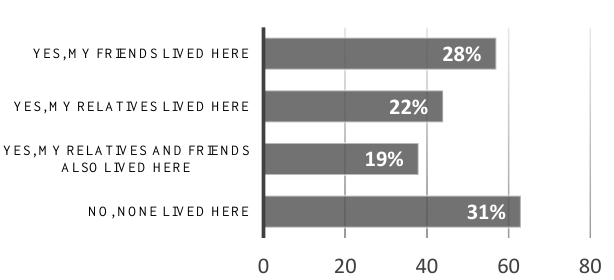
Figure 1. VFR relationships of Chinese immigrants before settling in Hungary.